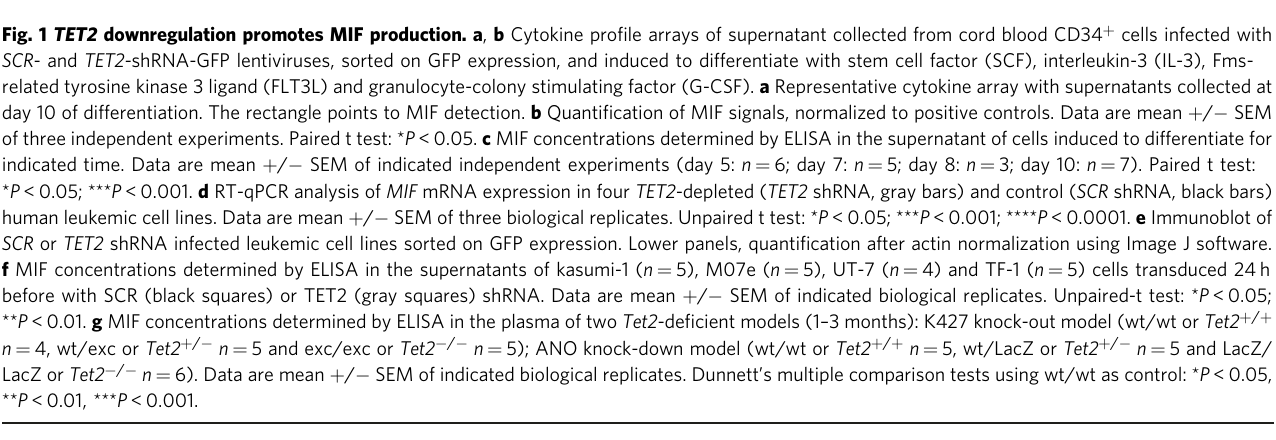
Fig. 1 TET2 downregulation promotes MIF production. a , b Cytokine pro fi le arrays of supernatant collected from cord blood CD34 + cells infected with SCR - and TET2- shRNA-GFP lentiviruses, sorted on GFP expression, and induced to differentiate with stem cell factor (SCF), interleukin-3 (IL-3), Fms- related tyrosine kinase 3 ligand (FLT3L) and granulocyte-colony stimulating factor (G-CSF). a Representative cytokine array with supernatants collected at day 10 of differentiation. The rectangle points to MIF detection. b Quanti fi cation of MIF signals, normalized to positive controls. Data are mean + / − SEM of three independent experiments. Paired t test: * P < 0.05. c MIF concentrations determined by ELISA in the supernatant of cells induced to differentiate for indicated time. Data are mean + / − SEM of indicated independent experiments (day 5: n = 6; day 7: n = 5; day 8: n = 3; day 10: n = 7). Paired t test: * P < 0.05; *** P < 0.001. d RT-qPCR analysis of MIF mRNA expression in four TET2 -depleted ( TET2 shRNA, gray bars) and control ( SCR shRNA, black bars) human leukemic cell lines. Data are mean + / − SEM of three biological replicates. Unpaired t test: * P < 0.05; *** P < 0.001; **** P < 0.0001. e Immunoblot of SCR or TET2 shRNA infected leukemic cell lines sorted on GFP expression. Lower panels, quanti fi cation after actin normalization using Image J software. f MIF concentrations determined by ELISA in the supernatants of kasumi-1 ( n = 5), M07e ( n = 5), UT-7 ( n = 4) and TF-1 ( n = 5) cells transduced 24 h before with SCR (black squares) or TET2 (gray squares) shRNA. Data are mean + / − SEM of indicated biological replicates. Unpaired-t test: * P < 0.05; ** P < 0.01. g MIF concentrations determined by ELISA in the plasma of two Tet2 -de fi cient models (1 – 3 months): K427 knock-out model (wt/wt or Tet2 + / + n = 4, wt/exc or Tet2 + / − n = 5 and exc/exc or Tet2 − / − n = 5); ANO knock-down model (wt/wt or Tet2 + / + n = 5, wt/LacZ or Tet2 + / − n = 5 and LacZ/ LacZ or Tet2 − / − n = 6). Data are mean + / − SEM of indicated biological replicates. Dunnett ’ s multiple comparison tests using wt/wt as control: * P < 0.05, ** P < 0.01, *** P <